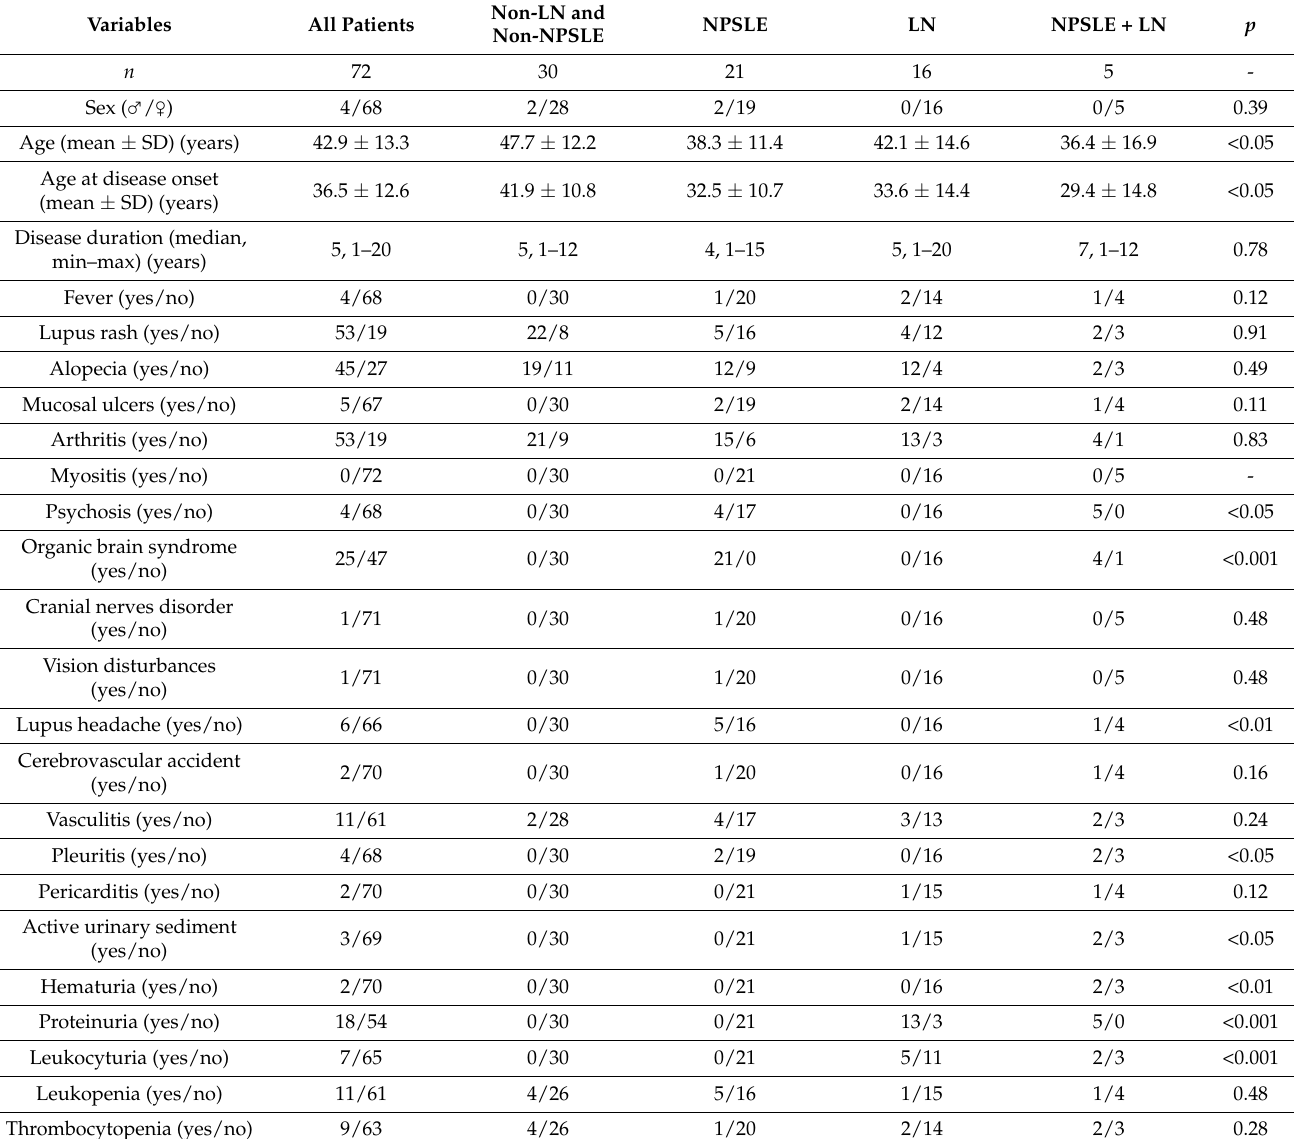
Table 1. Clinical characteristics of the study group and neuropsychiatric lupus/lupus nephritis